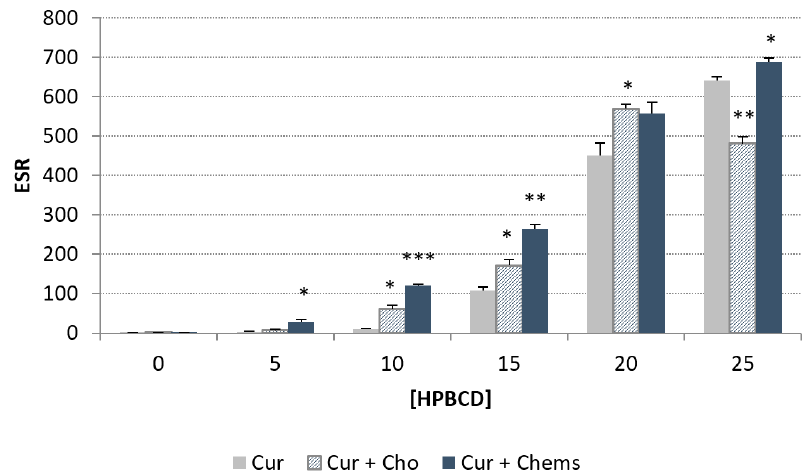
Figure 6. Enhancement solubility ratio (ESR) of Cur in different concentrations of HP β CD compared